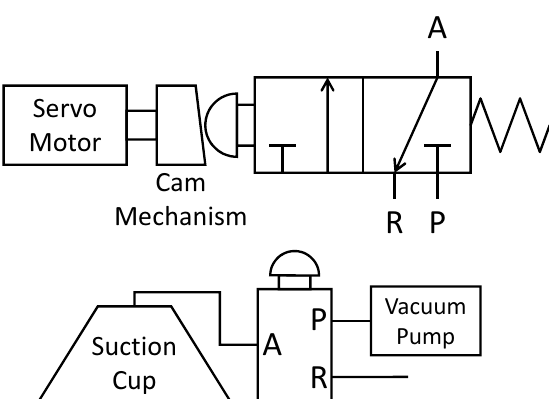
Figure 10. A diagram of the vacuum system. Top : The switching valve is controlled by the RC servo motor via a cam mechanism. Bottom : Chamber air in the suction cup is sucked once the toggle is pushed in.